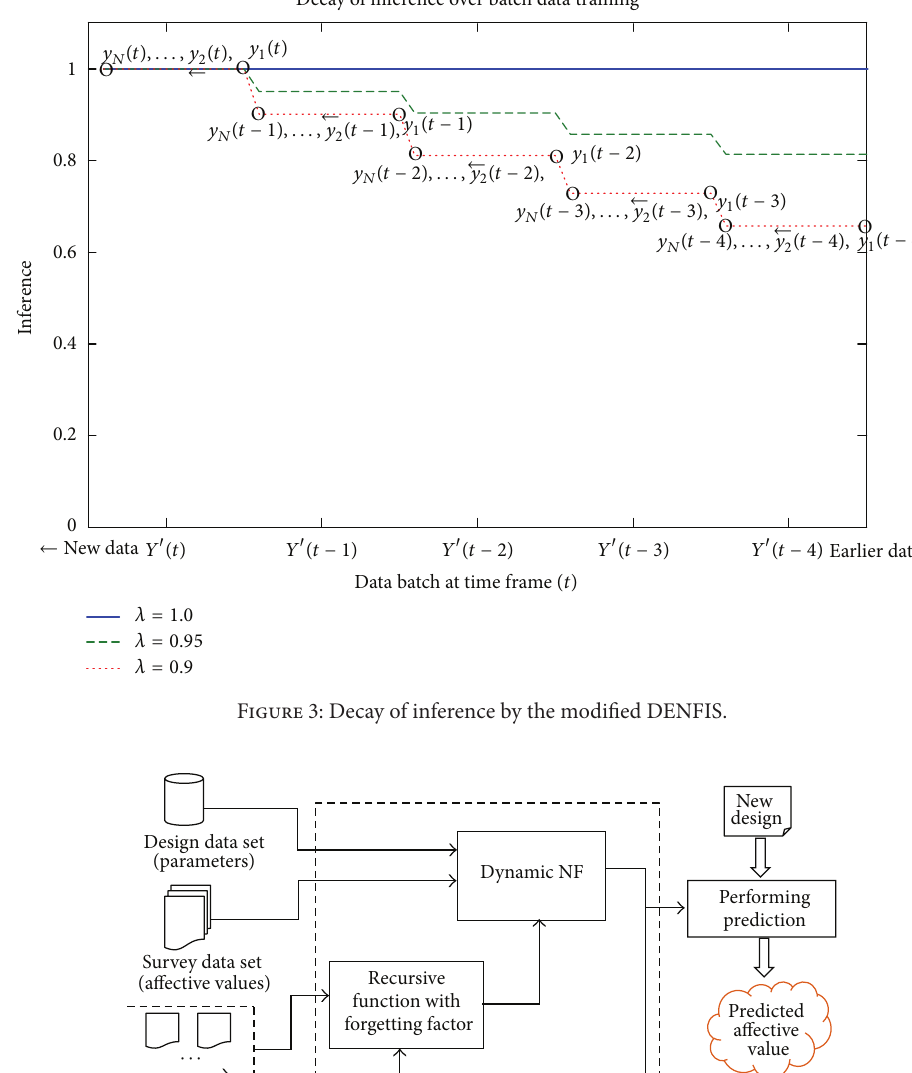
Figure 4: A dynamic NF model for affective